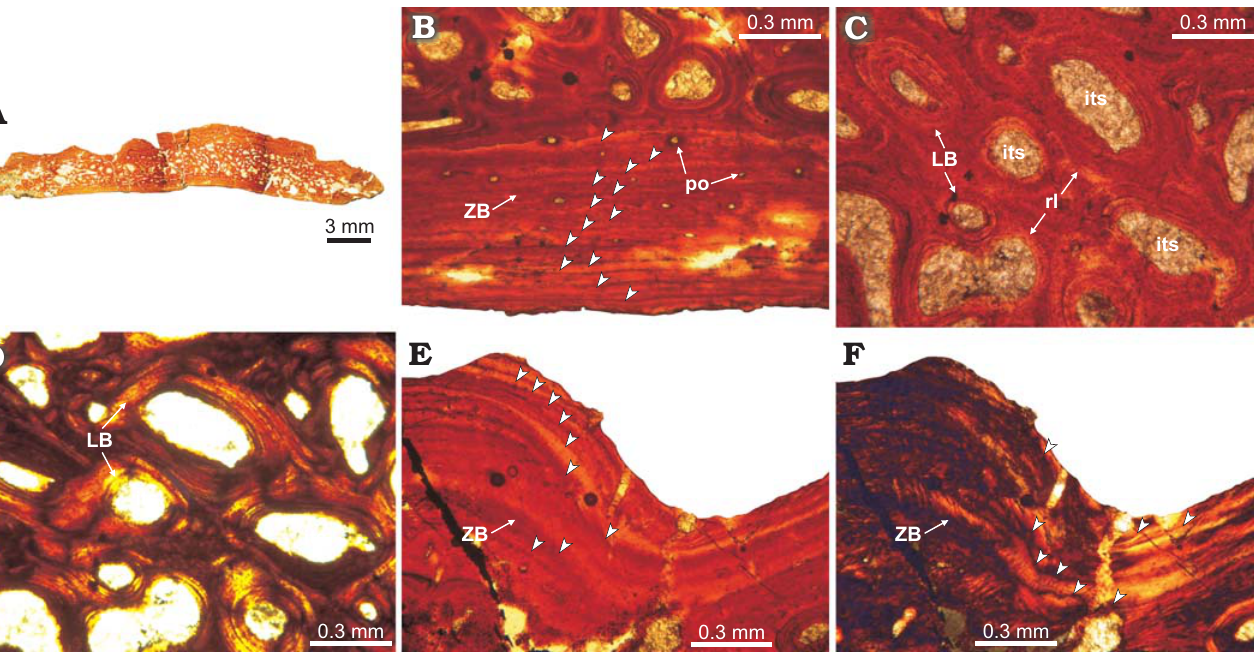
Fig. 3. Osteoderm histology of doswelliid Doswellia kaltenbachi Weems, 1980, USNM PAL 244214 from near Doswell, Virginia, USA, Carnian. A . Complete transversal section view; the deep excavations correspond with natural fractures of the element. B . Detail of the basal cortex; exhibits poorly vascularized primary zonal bone (arrowheads pointing to areas of parallel-fibered bone and annuli of lamellar bone). C , D . View of the internal core region; showing abundant intertrabecular spaces and vascular cavities, surrounded by secondary lamellar tissue and remains of woven-fibered bone of primary origin. E , F . Detail of the ornamentation in external cortex; consisting of poorly vascularized zonal bone; arrowheads pointing to growth marks (annuli) following the sculpted shape of the external surface. Note the absence of Sharpey’s fibres. A, B, C, E, normal light; D, F, cross-polarized light. Abbreviations: ZB, zonal bone; LB, lamellar bone; its, intertrabecular space; po, primary osteon; rl, resorption